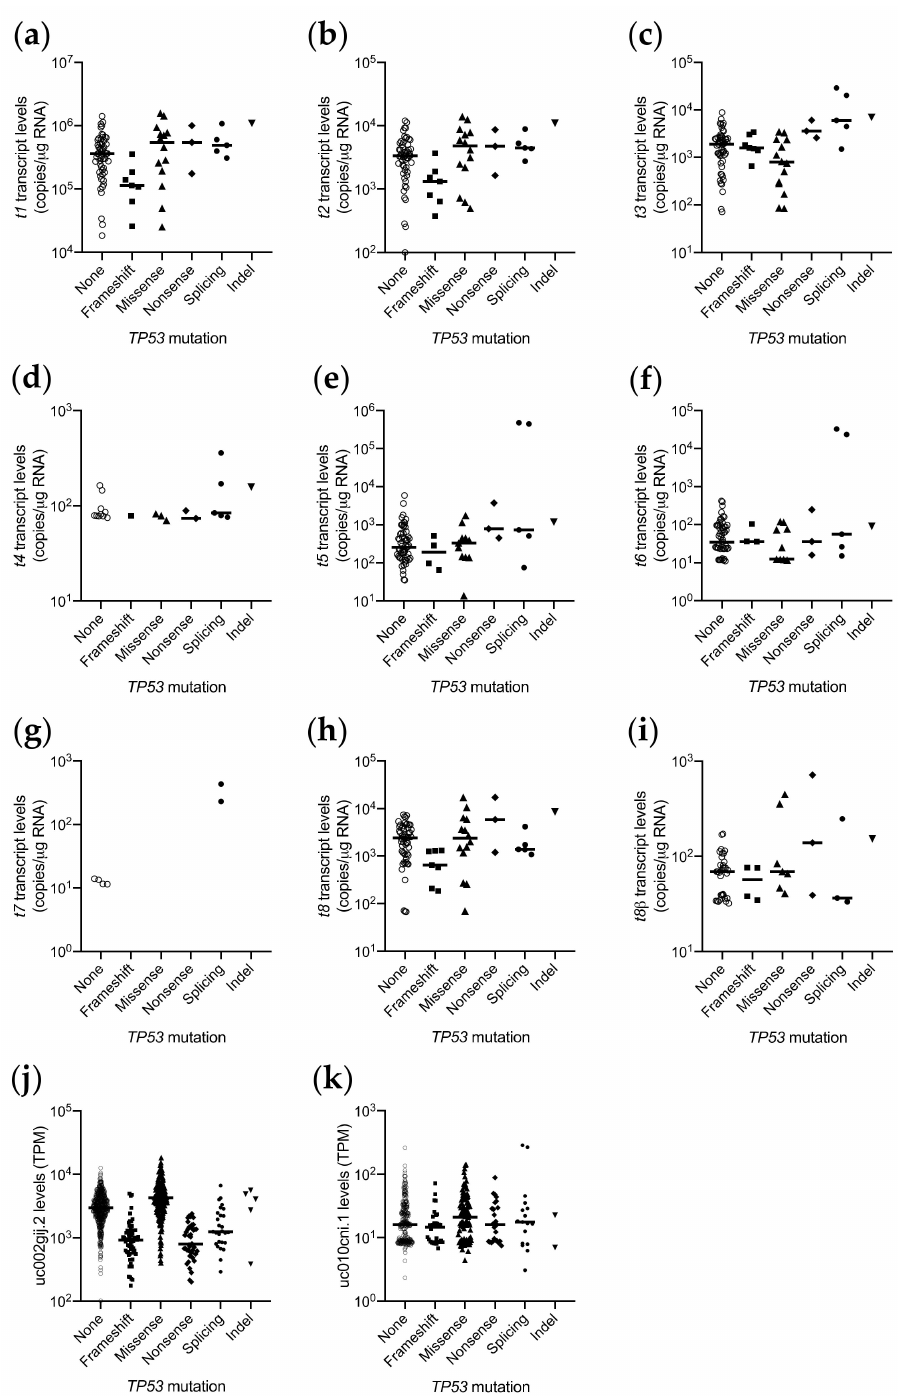
Figure 5. Scatterplots showing TP53 transcript abundance by TP53 mutation status in breast cancer cohorts. ( a – i ) TP53 transcript levels in New Zealand breast cancer cohort, quantitated by long amplicon ddPCR. ( a ) LRG_321t1 encoding FL/ ∆ 40p53 α , ( b ) LRG_321t2 encoding FL/ ∆ 40p53 α , ( c ) LRG_321t3 encoding FL/ ∆ 40p53 β , ( d ) LRG_321t4 encoding FL/ ∆ 40p53 γ , ( e ) LRG_321t5 encoding ∆ 133p53 α , ( f ) LRG_321t6 encoding ∆ 133p53 β , ( g ) LRG_321t7 encoding ∆ 133p53 γ , ( h ) LRG_321t8 encoding ∆ 40p53 α , and ( i ) t8 β encoding ∆ 40p53 β , in each tumor. ( j , k ) TP53 transcript levels from the TCGA BRCA cohort, quantitated by RNA-seq, ( j ) uc002gij.2, encoding FL/ ∆ 40p53 α , ( k ) uc010cni.1, encoding FL/ ∆ 40p53 β . Bar represents the median, with symbols representing individual tumor